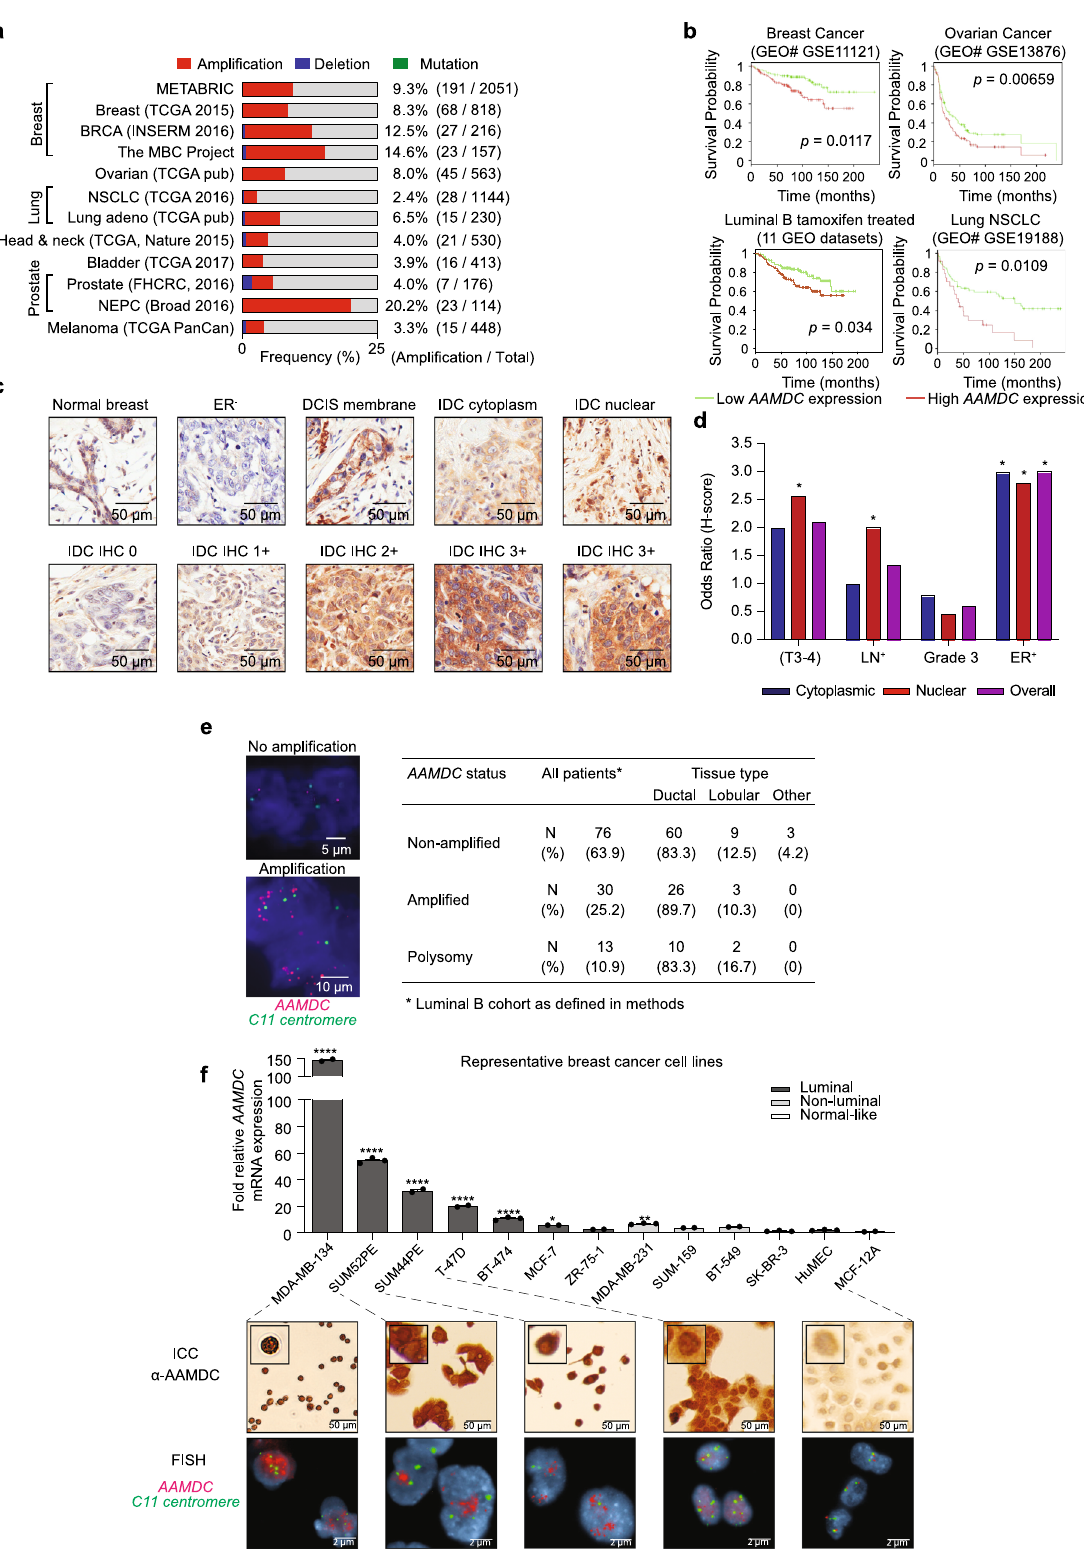
signi fi cant increase in apoptosis (Supplementary Fig. 1e). Fur- thermore, the AAMDC KDs reduced cell migration (Fig. 2d), a fi nding consistent with altered F-actin organization (Fig. 2e) and signi fi cantly decreased xenograft tumor burden in mice (Fig. 2f). Analysis of DepMap CRISPR knockout screening data matched with available molecular data from the Cancer Cell